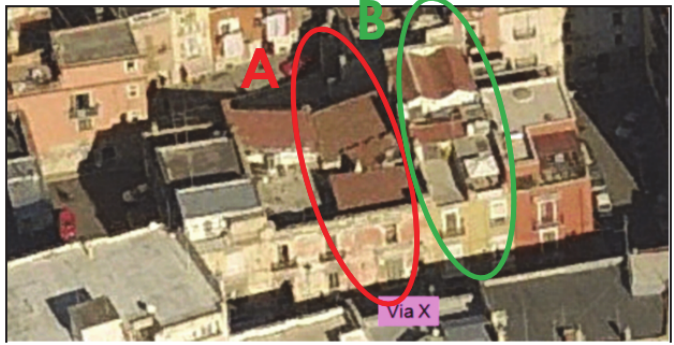
Figure 2: Aerial view of the considered group of adjacent buildings (from